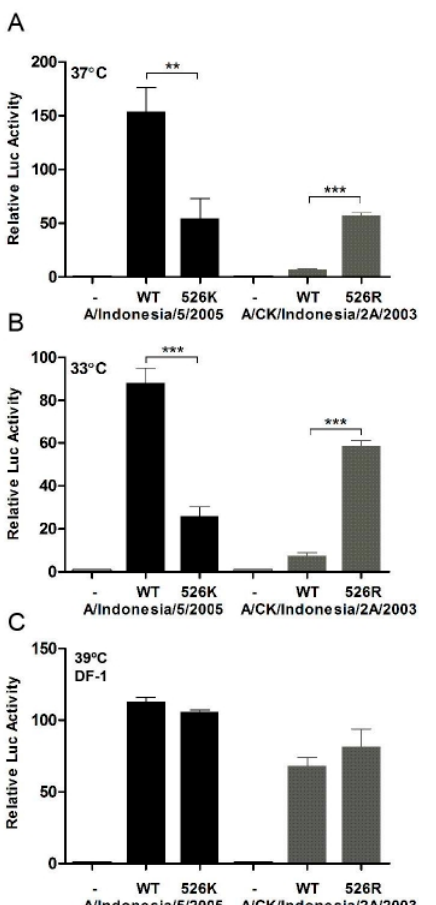
Figure 2. RNP polymerase activity in HEK293T and DF-1 cells. RNP expression plasmids containing NP, PB1, PA and wild type PB2, or the corresponding PB2 526 mutant derived from CK2A or IND5, along with a firefly luciferase RNP reporter plasmid and the Renilla luciferase expressing plasmid, pRL-TK (as an internal control), were transfected into HEK293T cells. The transfected cells were incubated for 24 h at: 37 ◦ C ( A ); or 33 ◦ C ( B ). DF-1 cells were transfected with the same sets of RNP complex plasmids but with an avian specific RNP firefly reporter and Renilla luciferase control ( C ). DF-1 cells were incubated at 39 ◦ C. Luciferase activities were measured at 24 h post transfection using a Dual-Luciferase Reporter Assay System (Promega). Firefly RNP activity was normalized against Renilla activity. RNP without PB2 was used as a negative control. Data represent mean normalized luciferase activity from three independent experiments. Error bars represent standard deviation calculated from three separate experiments. Statistical significance was analyzed by Student’s t -test. *** p < 0.001, ** p <